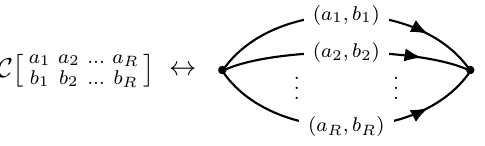
Figure 1 . Decorated dihedral graph with associated notation for modular graph